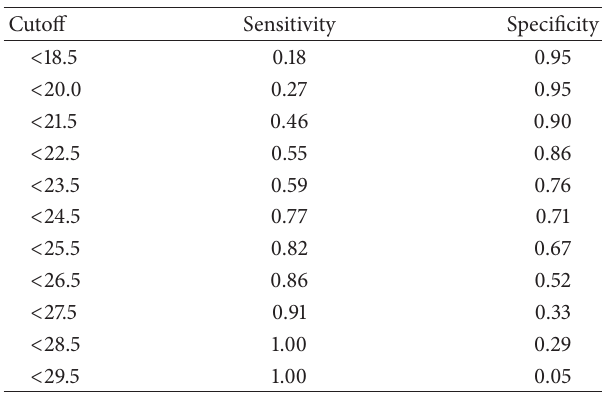
Table 3: Sensitivity and specificity of MMSE and MoCA for detecting PD-MCI at different cutoff values.